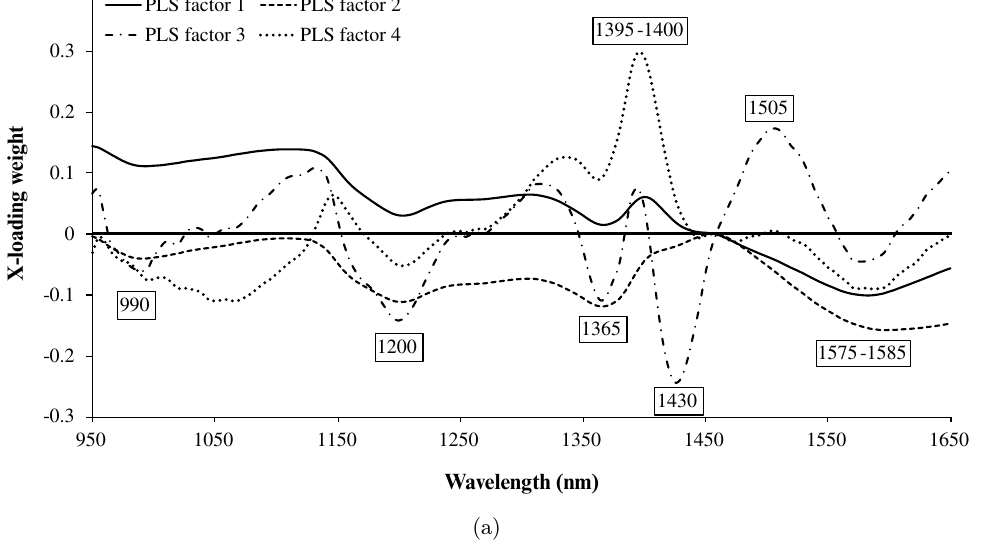
Fig. 3. X-loading weight plots of optimum models for moisture content in tapioca starch. (a) Tapioca starch cake samples. (b) Dried tapioca starch samples. (c) Combined tapioca starch